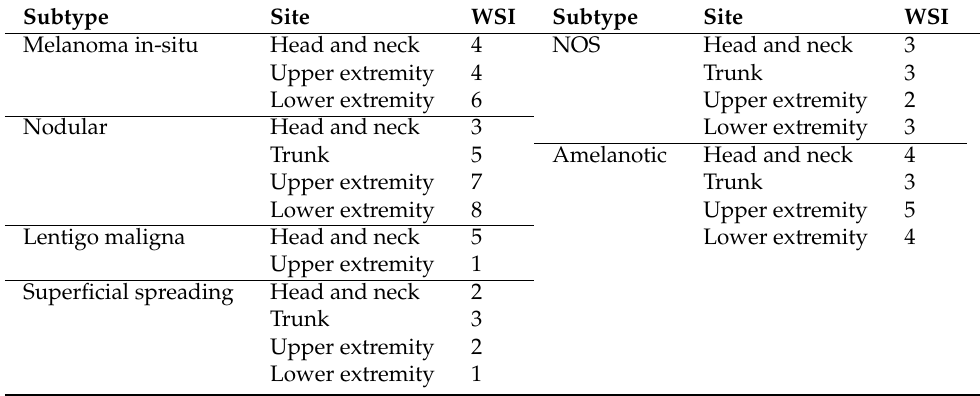
Table 1. The composition of the 78 melanoma subtype cases.